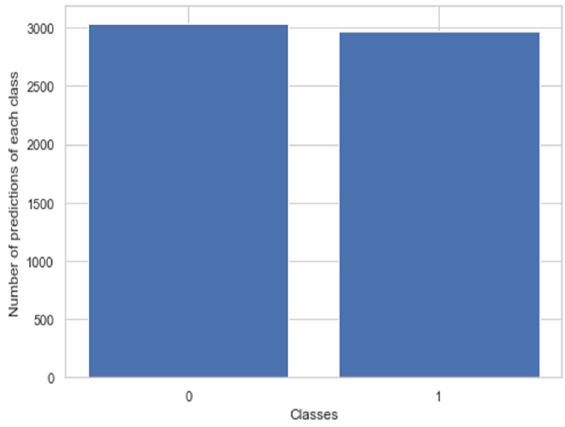
Figure 10. Prediction of classes of the test set images.